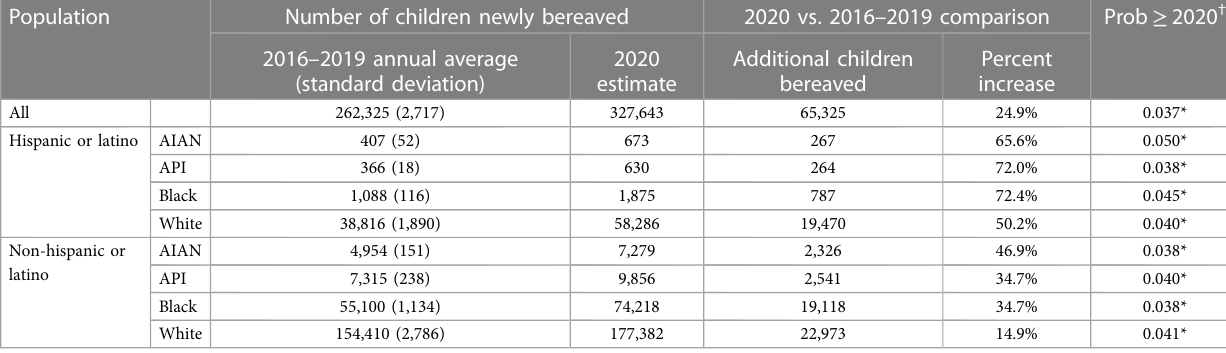
TABLE 2 Comparisons of CBEM parent death 2020 results with 2016 – 2019 average by population subgroup.